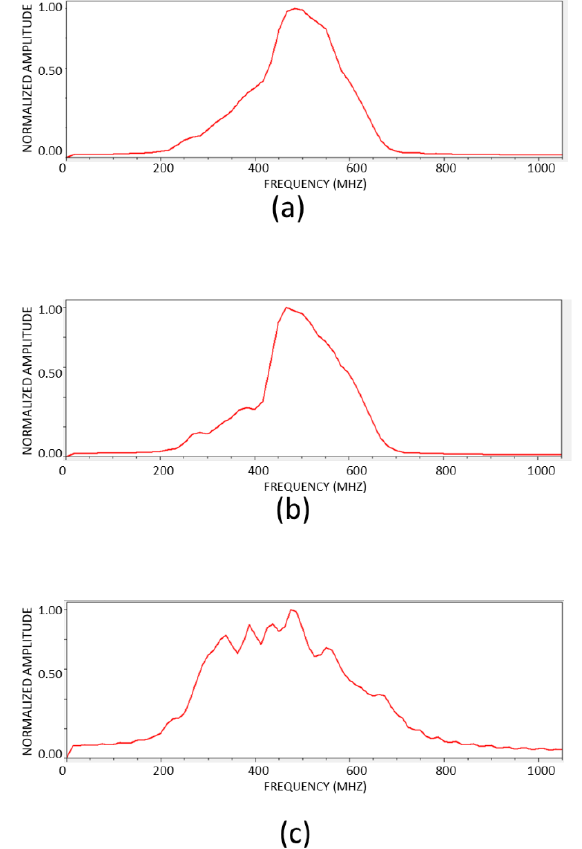
Figure 16. Frequency spectra of the mean trace related to the radargram acquired in S2 for WL3 ( a ), WL2 ( b ), and WL1 ( c ).